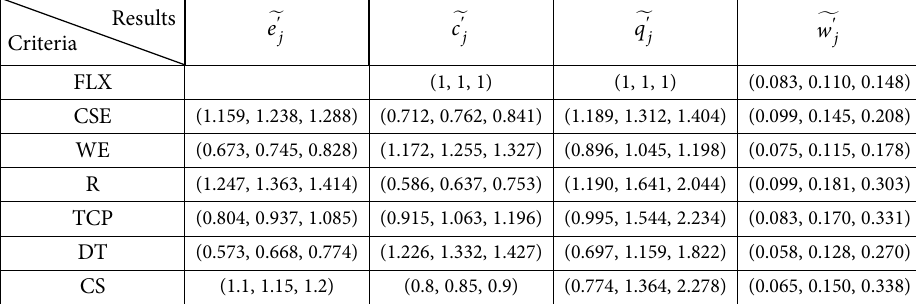
Table 7. The results of inverse fuzzy PIPRECIA Results Criteria